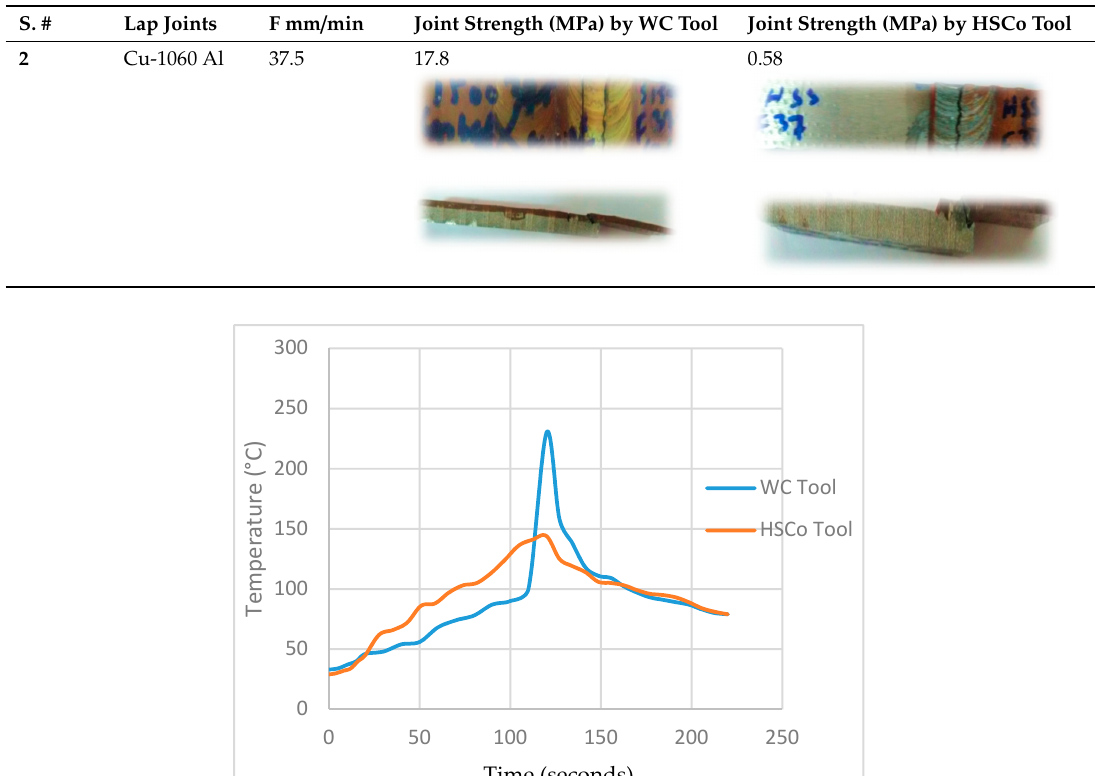
Table 6. Fabrication of 2219 Al-Cu (1.65 mm) lap joint using WC and HSCo square-pin tool ( T (cid:2888) : 22 seconds).